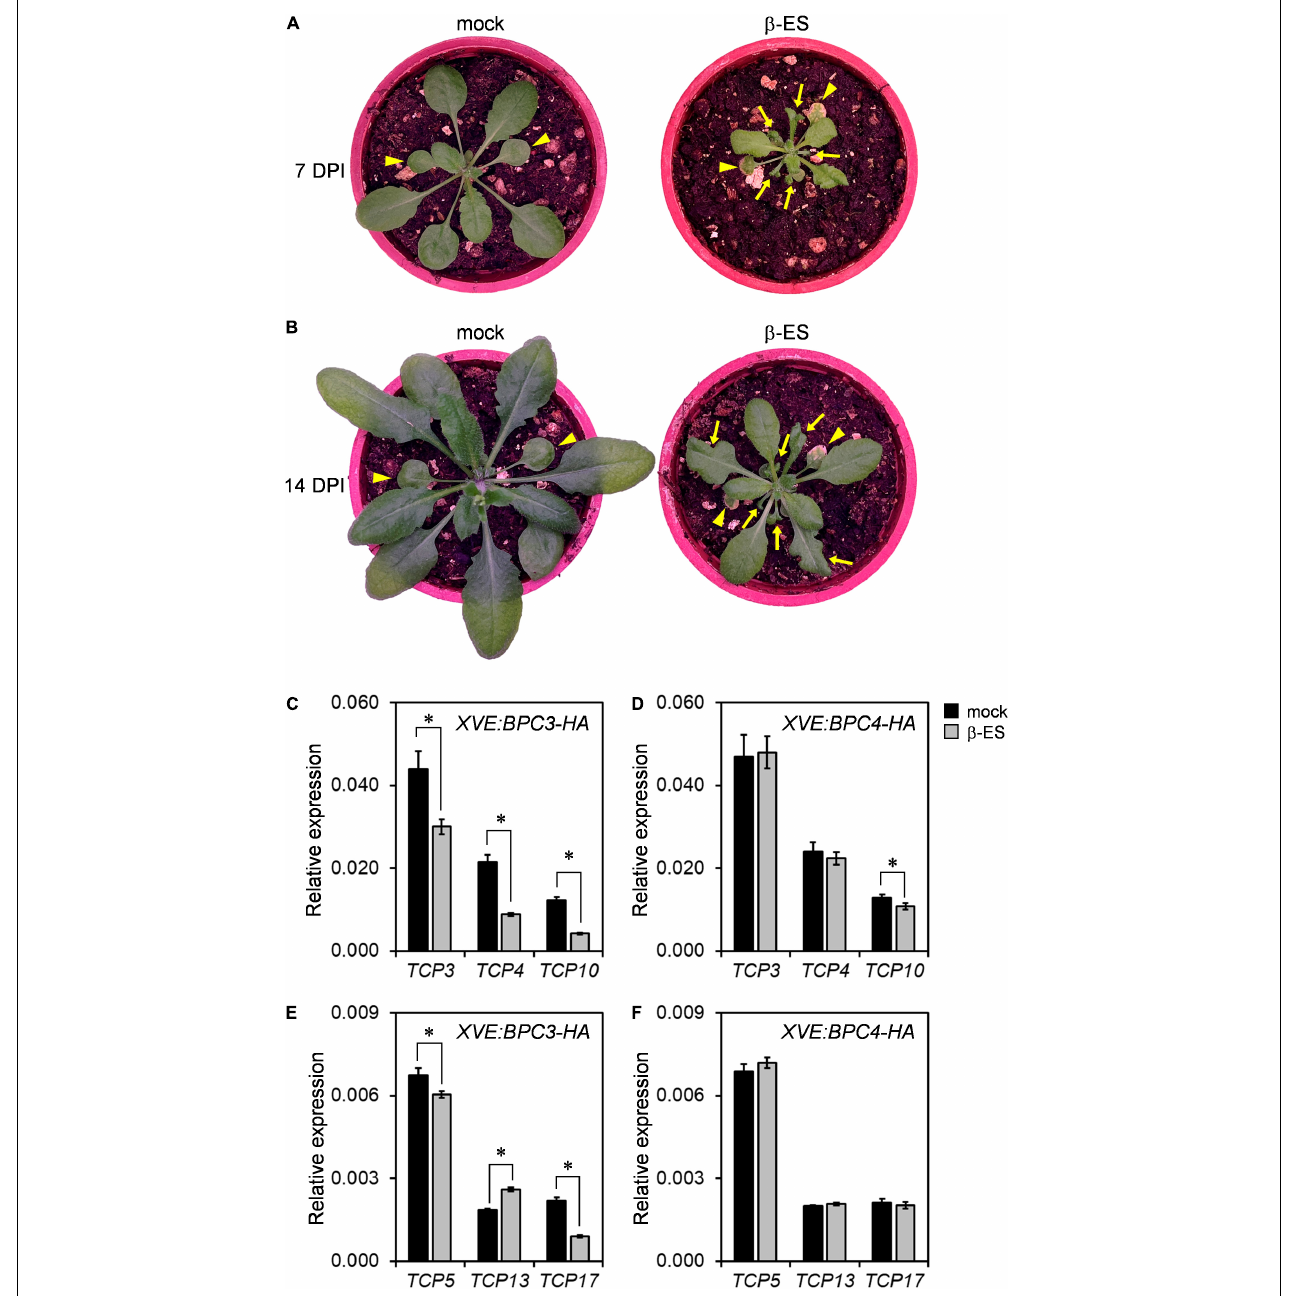
FIGURE 8 | The ectopic expression of BPC3 impedes leaf development and growth. (A,B) Plants of 14-day-old XVE:BPC3-EYFP-HA were imaged on the 7th (A) and 14th days (B) post induction (DPI) by 0 or 50 µ mM β -estradiol ( β -ES). Arrowheads indicate the first two true leaves. Arrows indicate the impeded growth and edge formation of younger leaves of the transgenic plants. (C,D) Expressions of TCP3 , TCP4 , and TCP10 were analyzed by qRT-PCR under the induction of XVE:BPC3-HA (C) and XVE:BPC4-HA (D) . (E,F) The expressions of TPC5 , TCP13 , and TCP17 were analyzed under indicated inductions. The expressions of the indicated TCPs were relative to that of UBQ10 . Data are mean ± S.E. ( n = 27, data collected as described in Figure 3 ; an independent biological replicate is presented in Supplementary Figures 10A–D , individual time points are shown in Supplementary Figure 11 ). Asterisks indicate expressions significantly changed by 50 µ mM β -ES treatment (Student’s t- test; ∗ P < 0.05).